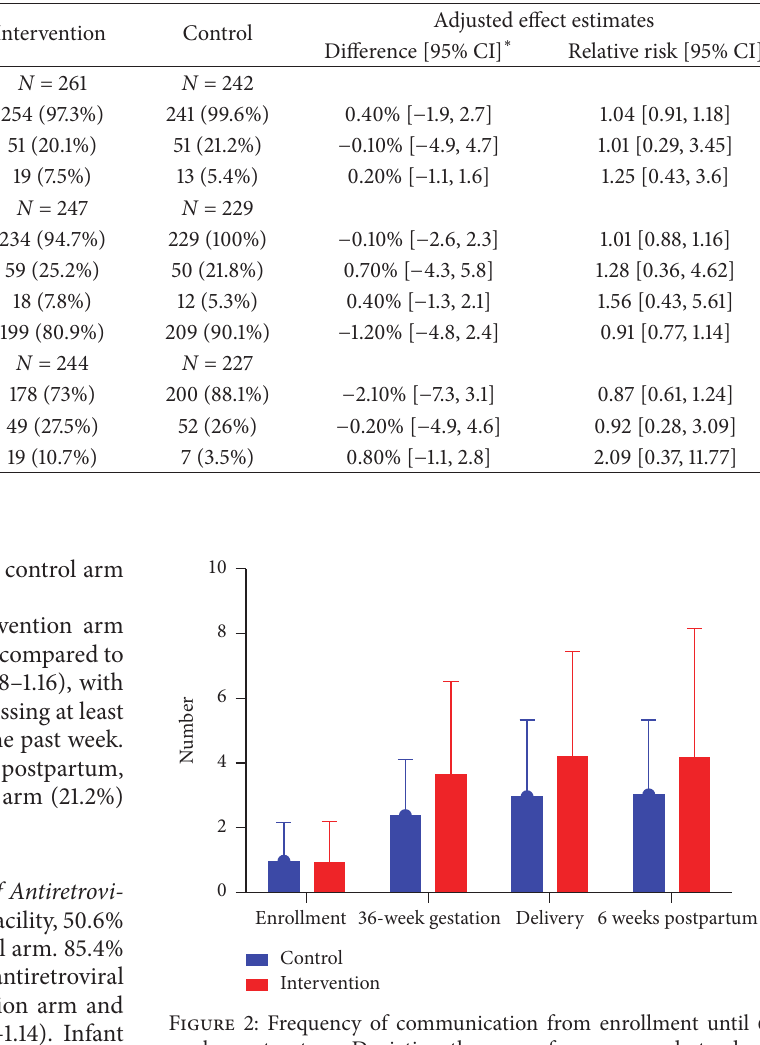
Table 2: Antiretroviral usage among study participants.